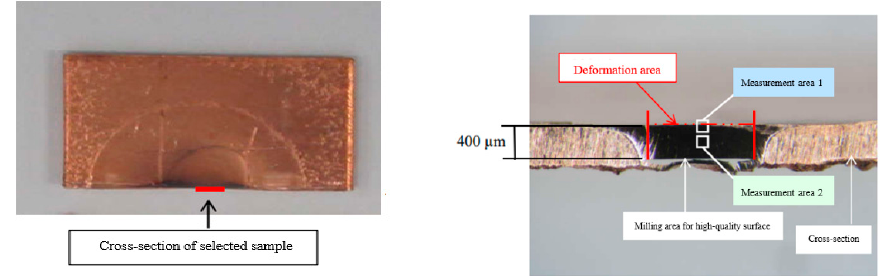
Figure 12. Schematic diagram of the EBSD mapping area.